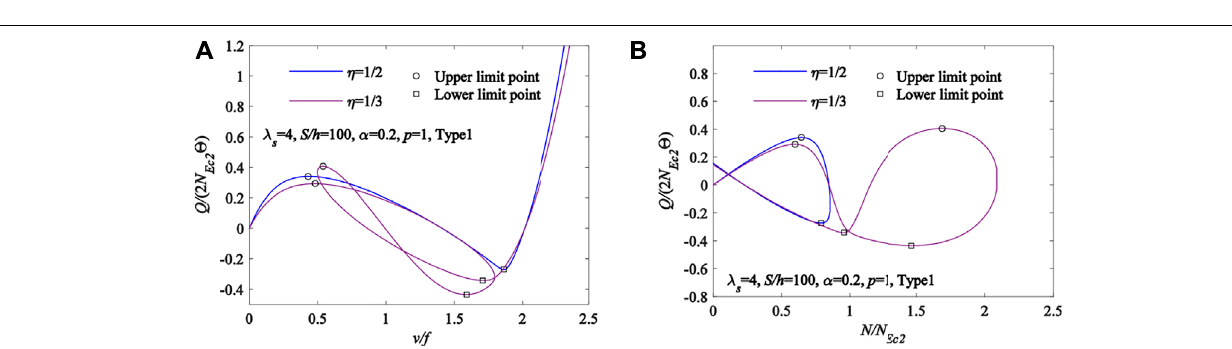
FIGURE 6 | Multiple limit point instability for pin-ended FGM arches using different localized parameters: (A) v / f − Q /(2 N Ec 2 Θ ) curves. (B) N / N Ec 2 − Q /(2 N Ec 2 Θ ) curves.